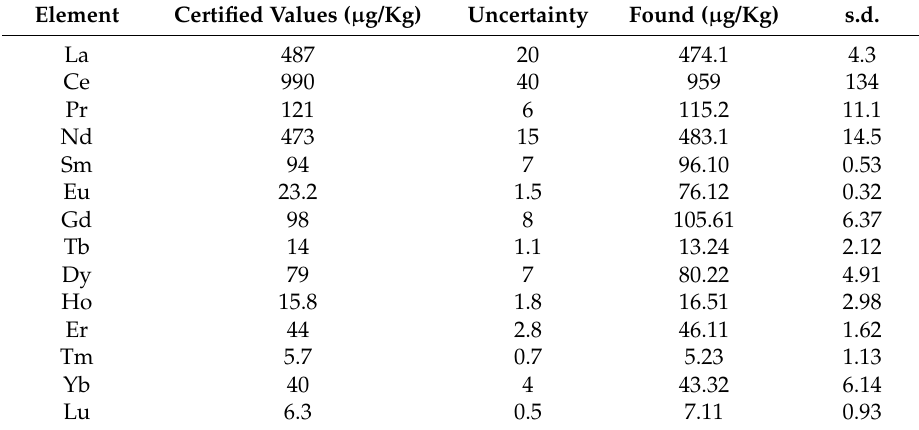
Table 2. Analysis of BCR 670 certified biological material (duckweed).